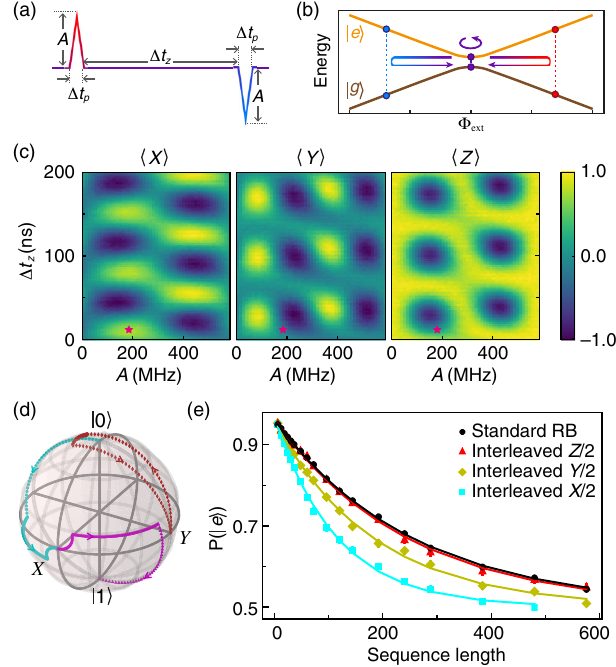
FIG. 4. Generic pulse scheme, gate calibration, and perfor- mance. (a) We use net-zero flux pulses as building blocks for universal control pulses. They are constructed using three sections, a positive triangular pulse with amplitude A and width Δ t on the fast-flux line, an idling period of Δ t , and, finally, p z another triangular pulse identical to the first one but with a negative amplitude. (b) Energy levels of the computational space as a function of the external flux ( Φ ) showing how the fast-flux ext pulse changes the energies of the instantaneous eigenstates. (c) Expectation values of σ , σ , and σ as a function of pulse x y z and A . These 2D sweeps are used to determine the parameters Δ t z optimal parameters for the Y= 2 and arbitrary Z gates. ⋆ indicates the parameters for a Y= 2 gate. (d) Trajectories of three distinct ffiffiffi p 2 initial states j 0 i (cyan), ðj 0 i þ j 1 iÞ = (magenta), and ðj 0 i þ ffiffiffi p 2 i j 1 iÞ = (brown) on the Bloch sphere when a Y= 2 gate is applied. (e) Comparison of standard RB (black circles) and interleaved RB for Z= 2 (red triangles), Y= 2 (gold diamonds), and X= 2 (cyan squares) gates. The plot is a result of 75 randomized gate sequences averaged over 10 000 times. The average gate 0 . 9980 , and the individual gate fidelities fidelity is F avg ¼ 0 . 9999 , F 0 . 9992 , and F 0 . 9976 [34]. are F Z= 2 ¼ Y= 2 ¼ X= 2 ¼ The uncertainties in all fidelities are smaller than the least significant